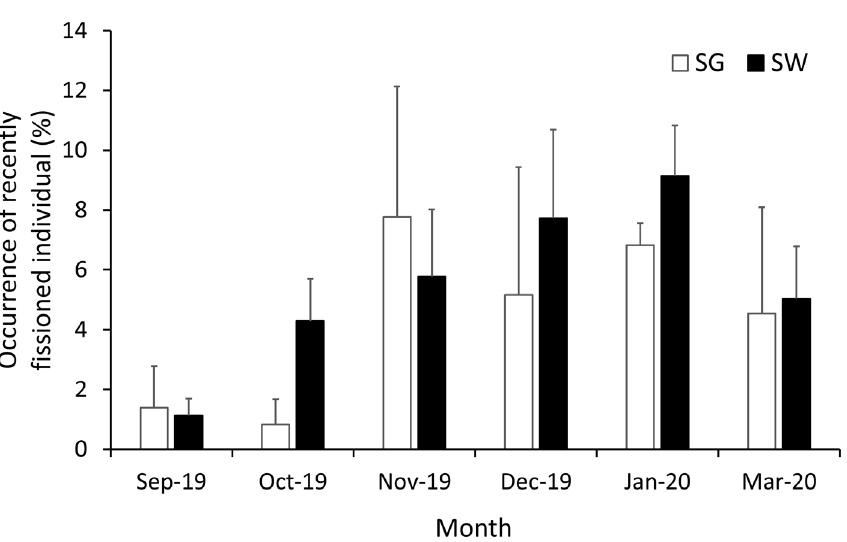
Figure 8. Occurrence of recently fissioned individuals (mean ± SE) in the seagrass habitat (SG) and seaweed habitat (SW), from September 2019 to March 2020.